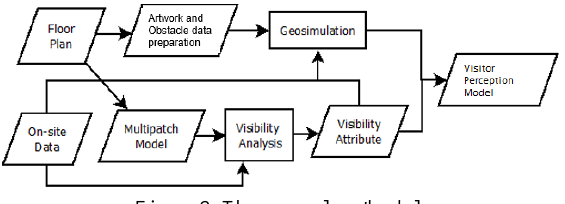
Figure 2. The general methodology